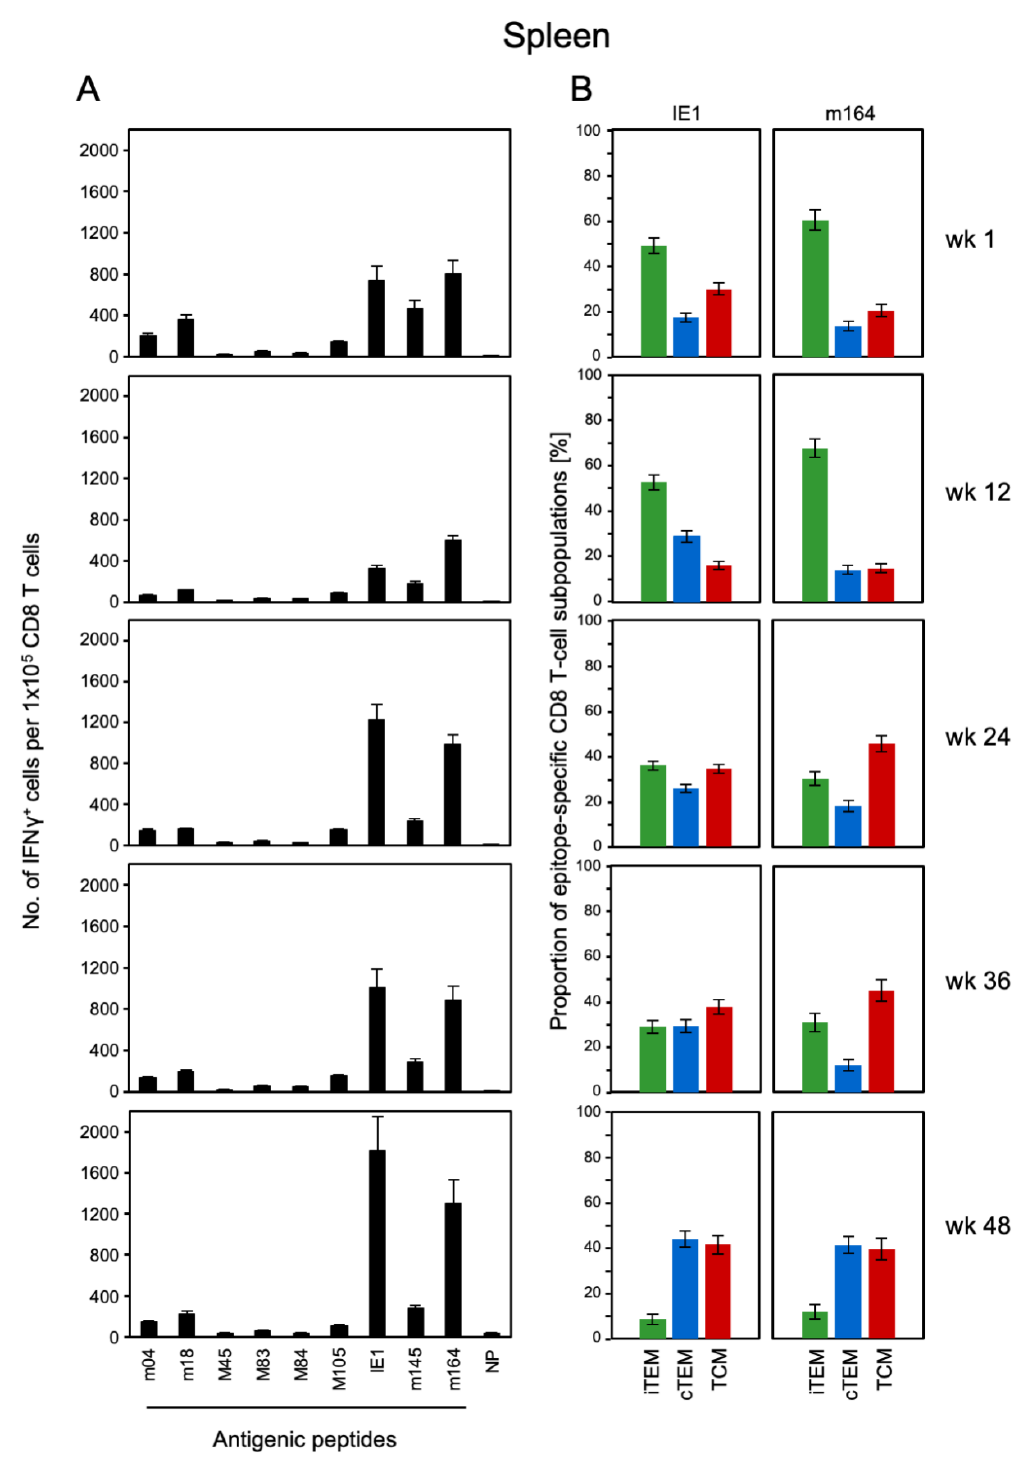
Figure 2. Kinetics of CD8 T-cell specificity repertoires and activation phenotypes in the spleen. At the indicated times after intraplantar infection with 10 5 PFU of mCMV, spleen-derived CD8 T cells were immunomagnetically purified from pools of 4–5 BALB / c mice. ( A ) Frequencies of mCMV epitope-specific CD8 T cells responding in the ELISpot assay with IFN- γ secretion to stimulation with P815 cells exogenously-loaded with the indicated synthetic peptides at saturating concentration of 10 − 6 M. NP, control with no peptide. Bars represent the most probable numbers, and error bars indicate the 95% confidence intervals determined by linear regression analysis. ( B ) Proportions of activation phenotypes of epitope-specific CD8 T cells defined by cytofluorometric analysis of KLRG1 and CD62L expression within gated dextramer-stained cells (for more detail, see Figure 1). iTEM (green bars), cTEM (blue bars), TCM (red bars). The standard error is